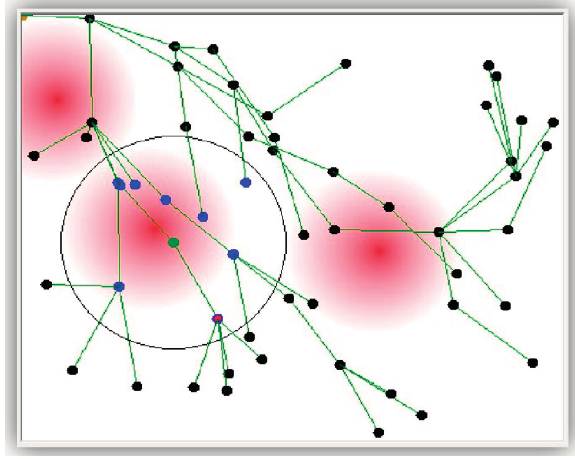
Figure 5. The monitored field with randomly deployed